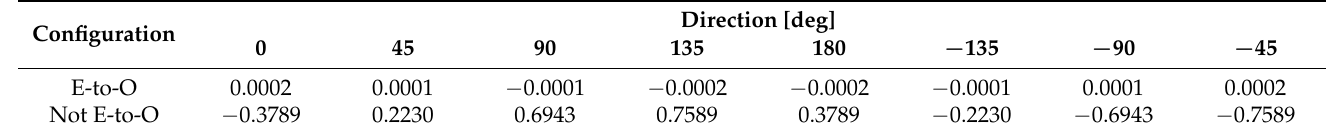
Table 5. Sum of velocity moments per unit command speed [m]—6-wheeled Omni wheel robots.